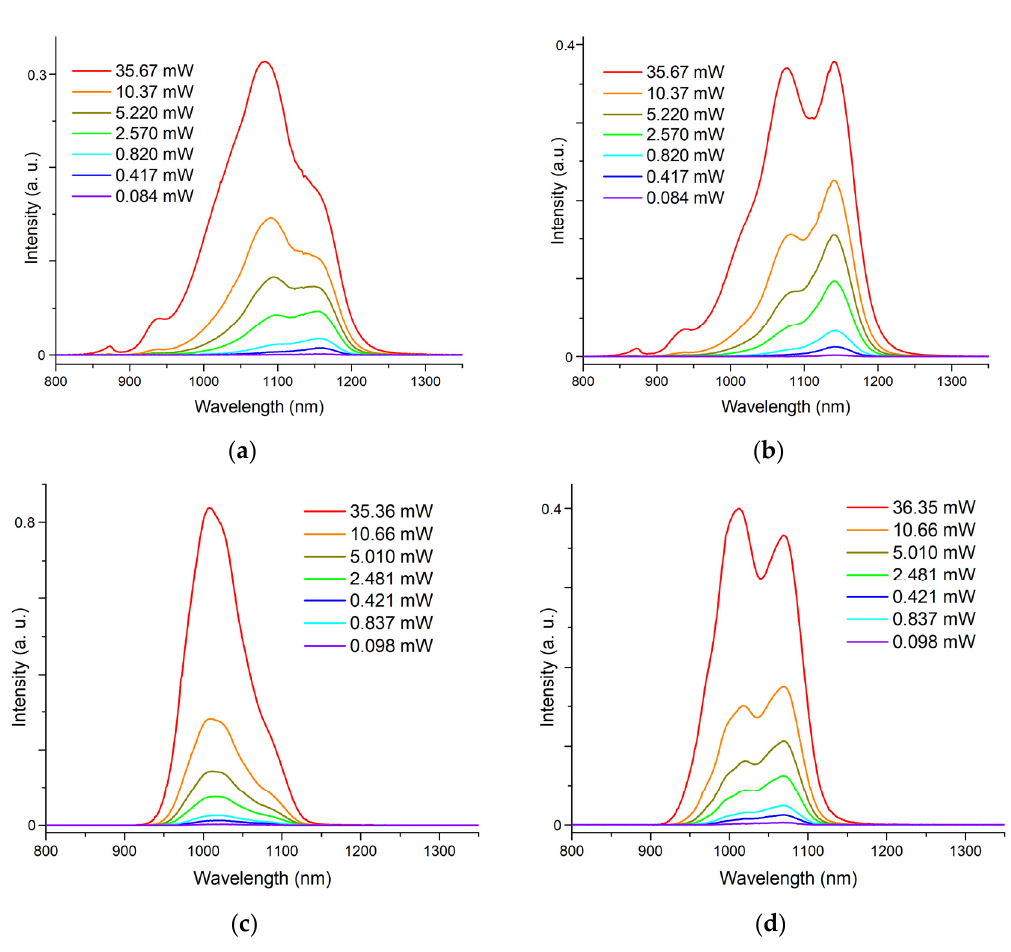
Figure 4. Excitation intensity-dependent PL spectra of QDs overgrown at the low arsenic pressure: ( a ) H = 5 nm (300 K); ( b ) H = 10 nm (300 K); ( c ) H = 5 nm (77 K); ( d ) H = 10 nm (77 K).